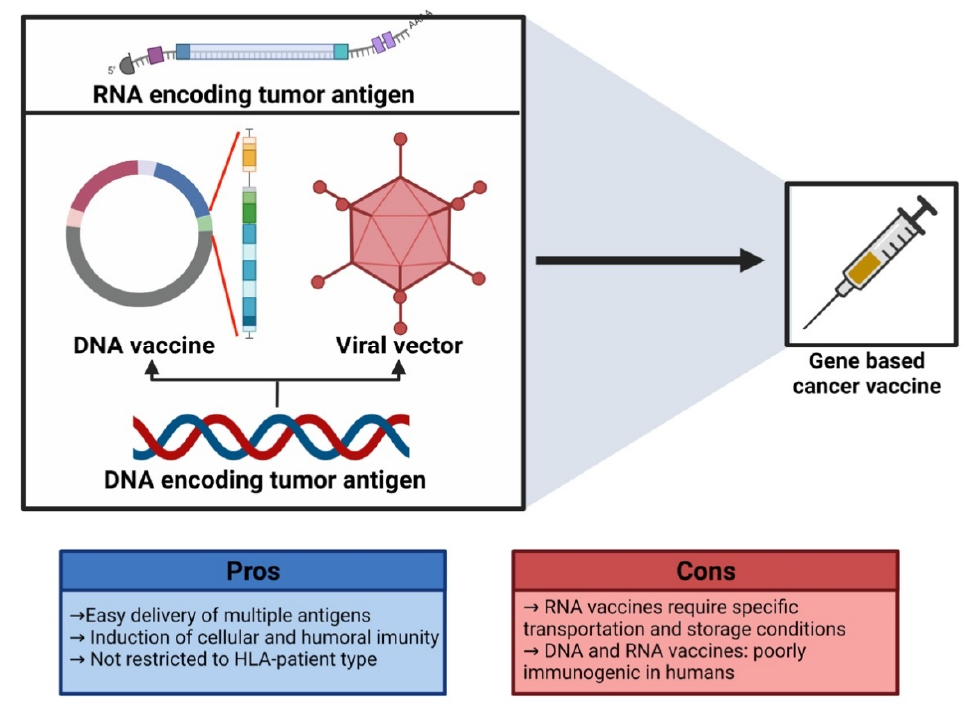
Figure 5 . Diagrammatical representation of gene - based cancer vaccines ( created with biorender . com ). Figure 5. Diagrammatical representation of gene-based cancer vaccines (created with